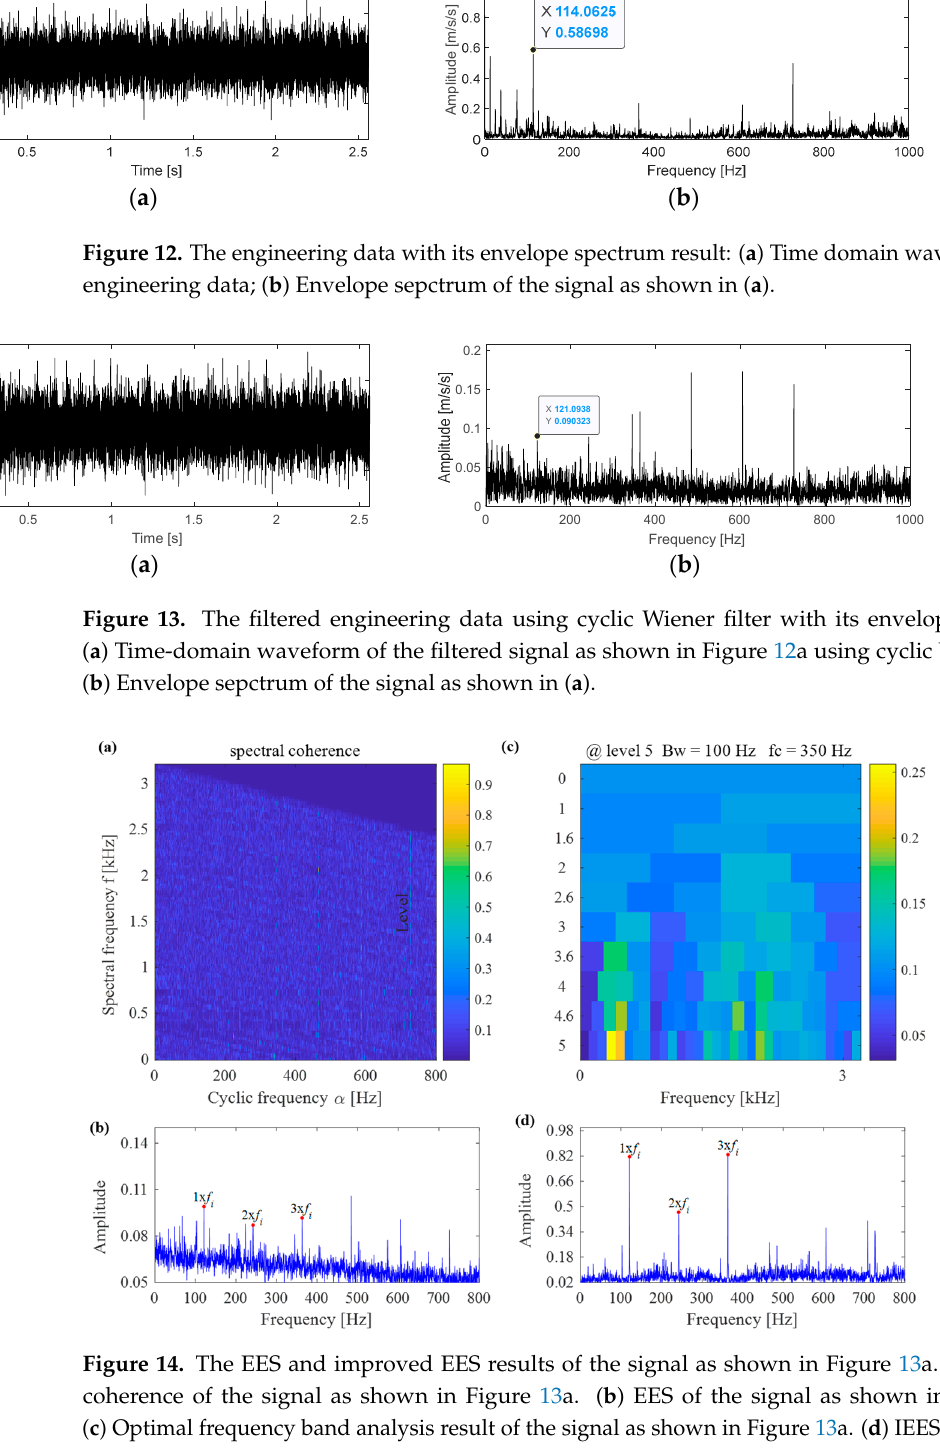
as shown in Figure 13a.